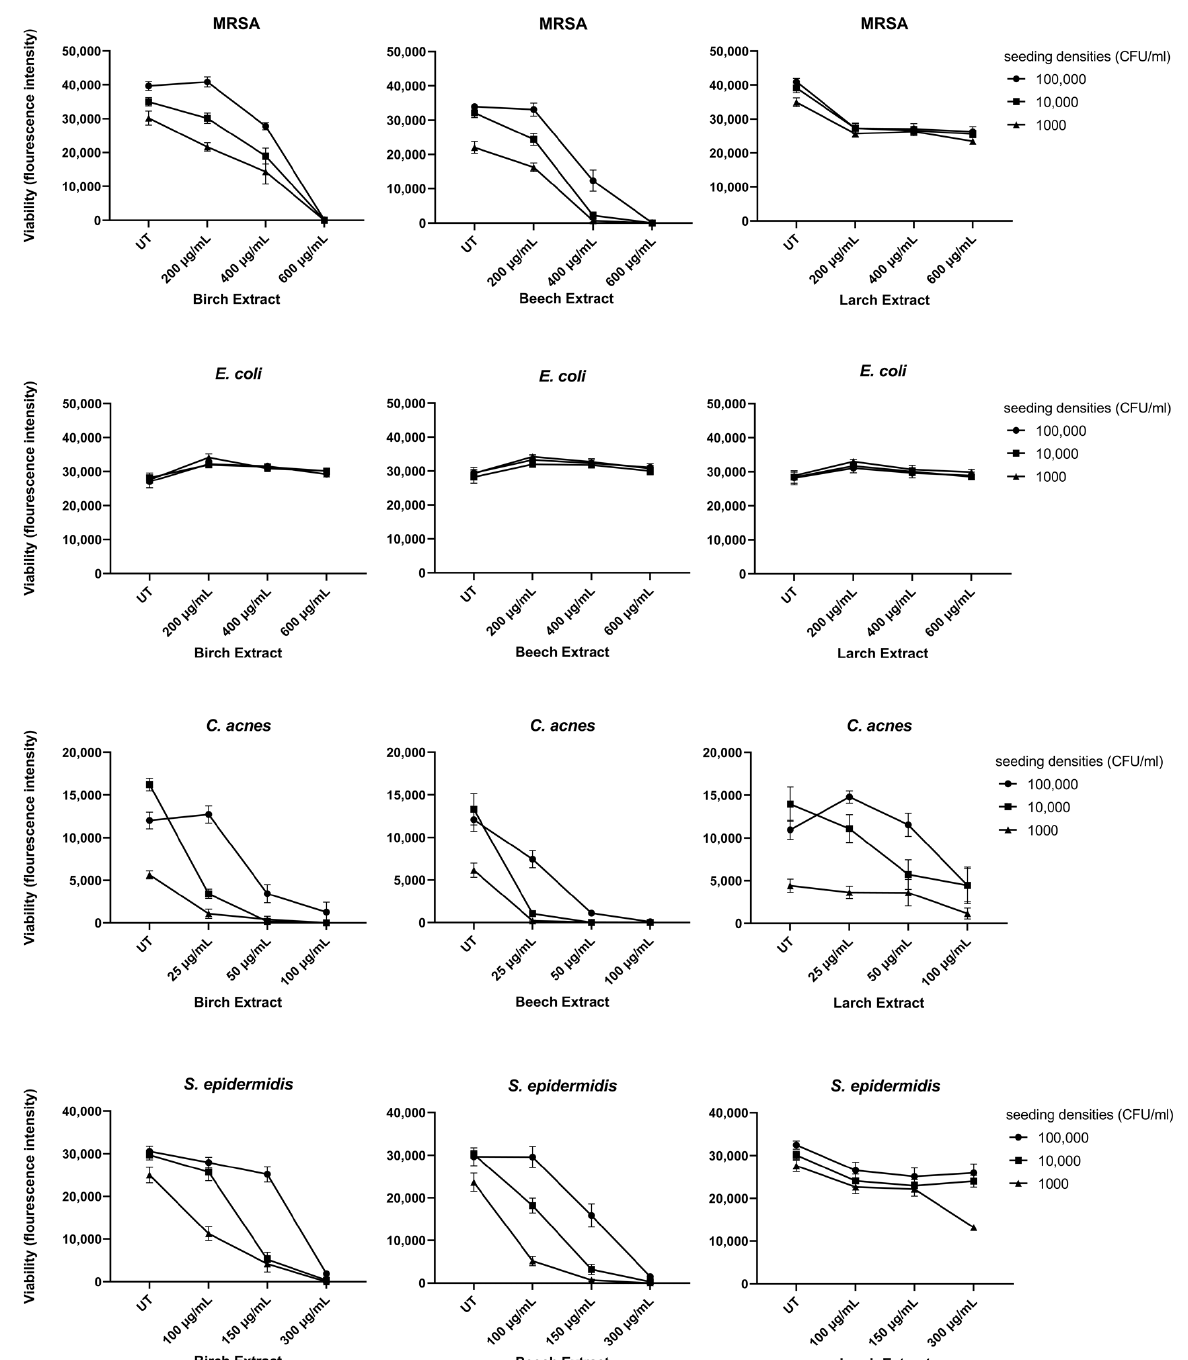
Figure 2. Resazurin viability assay results of the 4 bacterial strains; results are displayed as fluores- cence intensity (560 Ex/610